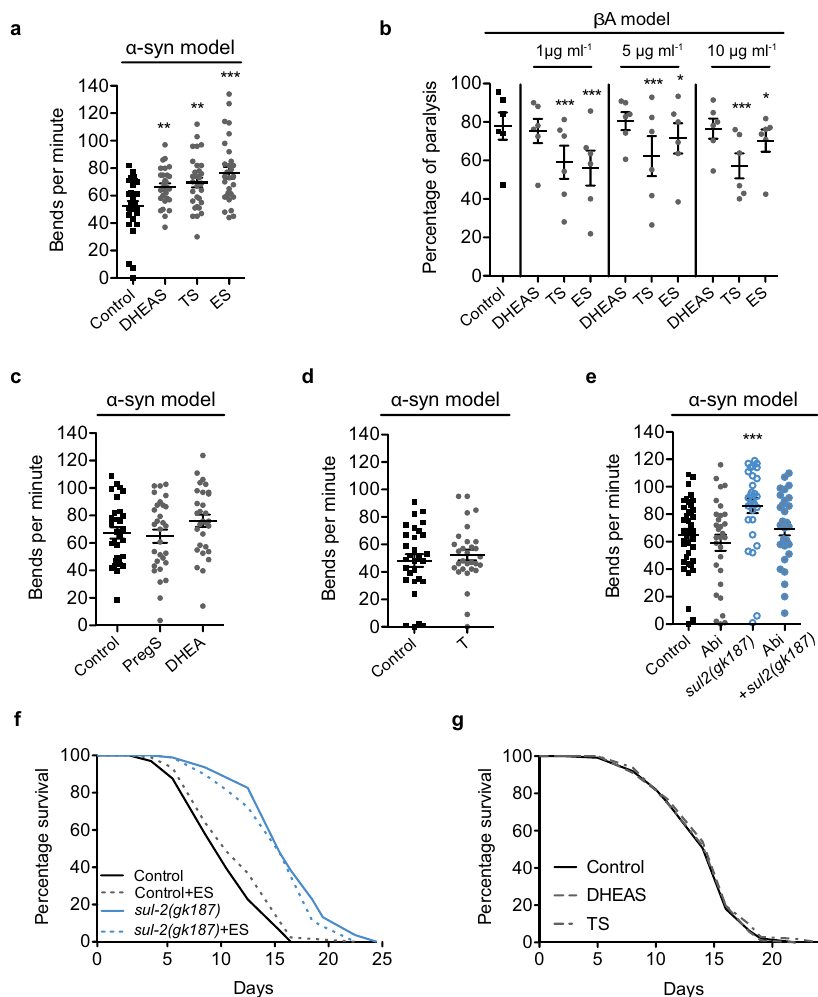
Fig. 5 Sulfated C19 androgen steroid hormones mimic sul-2 inactivation. a NL5901 strain expressing α -synuclein in muscle cells reduce mobility with age. Treatment with DHEAS, TS or ES improves the mobility (1 μ g/ml). Data from three biological replicates are displayed, n ≈ 30 worms per sample. Two- tailed Mann – Whitney t -test. b Paralysis of GMC101 Alzheimer ’ s disease model is ameliorated with TS and ES. Data display the percentages from